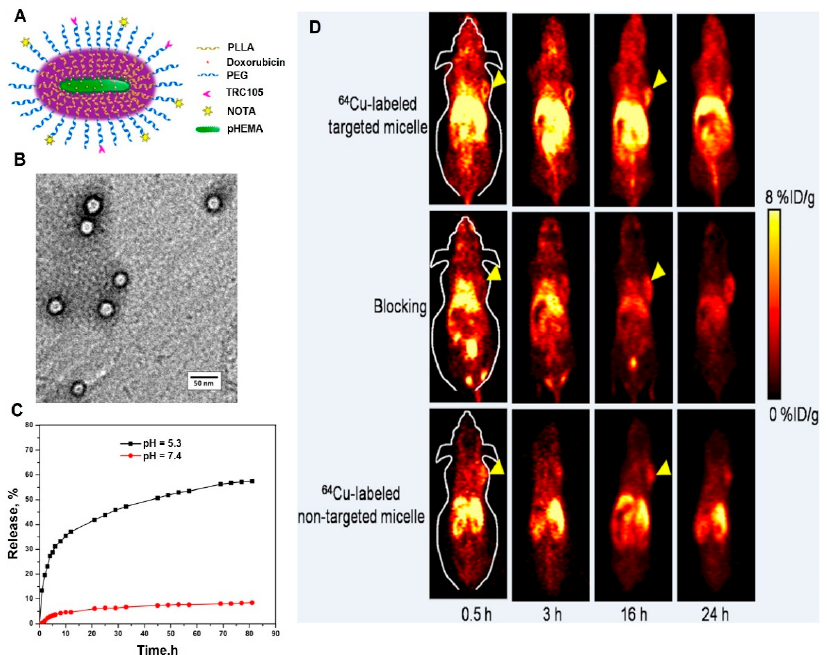
Figure 4. A schematic of the micelle ( A ); TEM micrograph of the micelle ( B ); the release rate of doxorubicin-loaded micelle at physiological and acidic mediums ( C ); the positron emission tomog- raphy images of 4T1 tumor-bearing mice treated with 64 Cu-labeled targeted, non-targeted micelles, and targeted micelles with a blocking dose of TRC105 at different time intervals ( D ). Reprinted from [55] with permission from American Chemical Society.